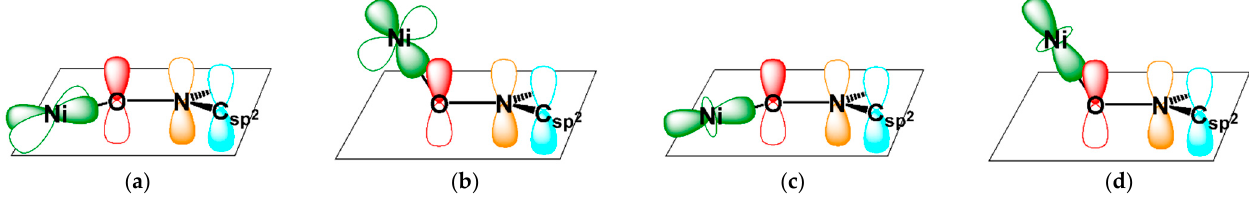
Figure 3. Arrangement of atomic orbitals, ( a , b ) Ni(3d x 2 − y 2 )–O(2p z )–N(2p z )–C sp 2 (2p z ) and ( c , d ) Ni(3d z 2 )–O(2p z )–N(2p z )– C sp 2 (2p z ). The Ni ions are ( a , c ) located on the π * nodal plane and ( b , d ) dislocated out of the plane. This picture is also applicable to other conventional organic radical ligands having a well-defined π * nodal plane.